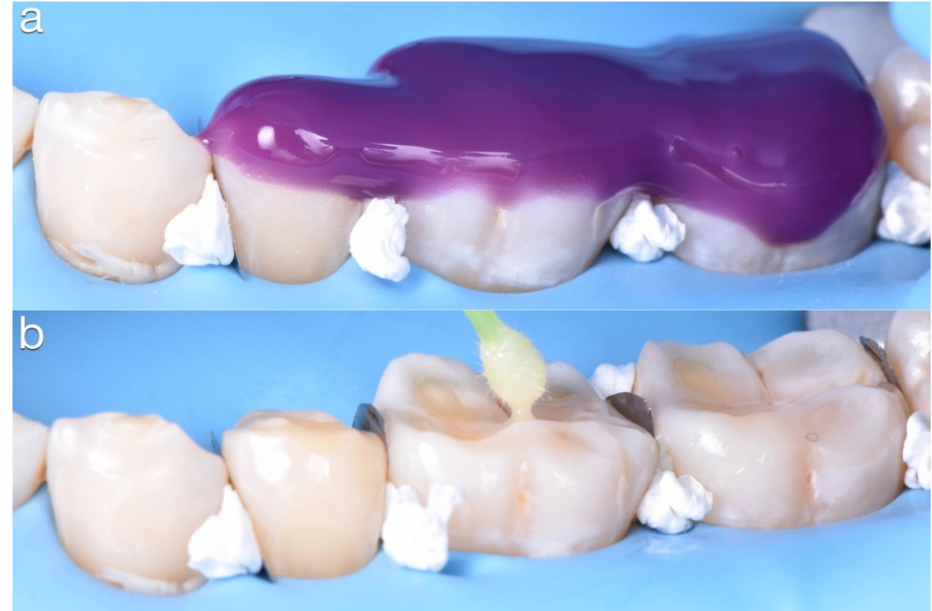
Figure 20. ( a ) Selective etching using 37% phosphoric acid for 30 s on enamel and 15 s on dentin, ( b ) Adhesive luting